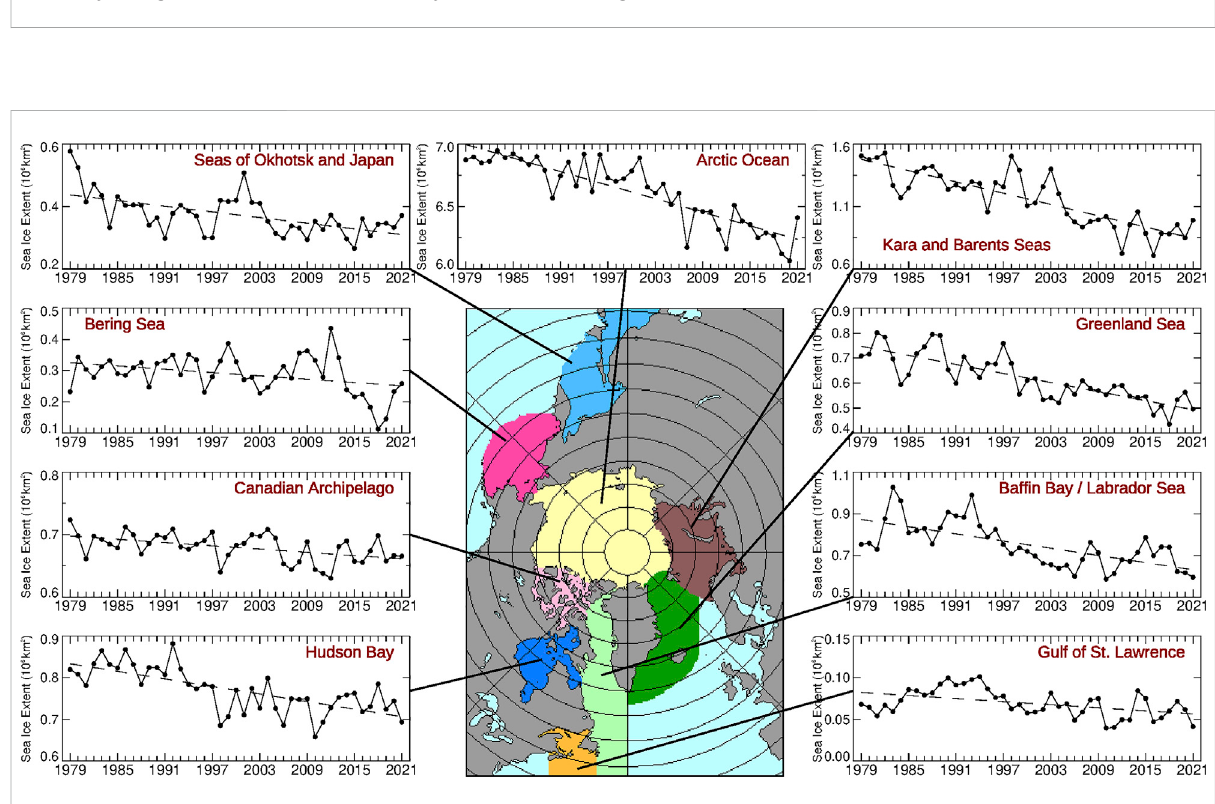
FIGURE 6 Yearly average sea ice extents and least-square trend lines, 1979 – 2021, for the following regions: Seas of Okhotsk and Japan; Bering Sea; Canadian Archipelago; Hudson Bay; Arctic Ocean; Kara and Barents Seas; Greenland Sea; Baf fi n Bay/Labrador Sea; and Gulf of St.